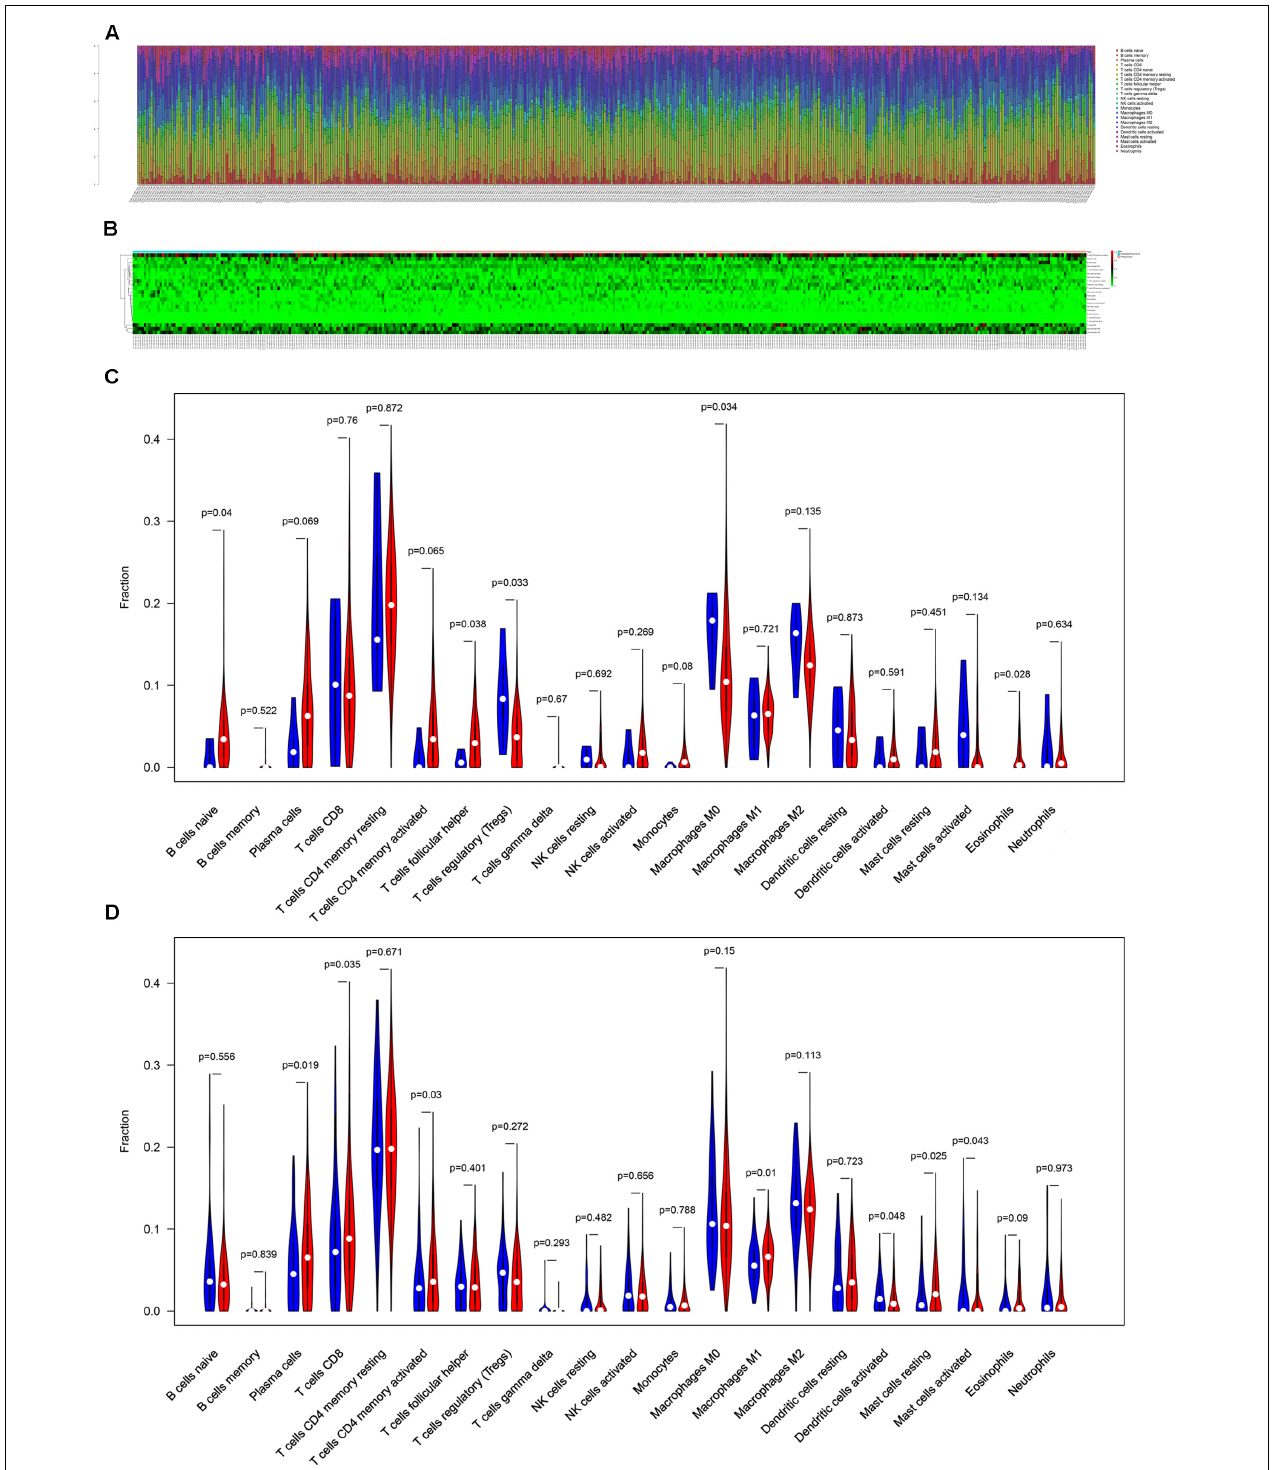
FIGURE 5 | The composition of immune cells assessed by CIBERSORT algorithm in colon cancer (A,B) and the identification of prominent tumor-infiltrating immune cells related to the distance metastasis of colon cancer (C) and associated with the metastasis and recurrence of it (D) . CIBERSORT: cell type identification by estimating relative subsets of RNA